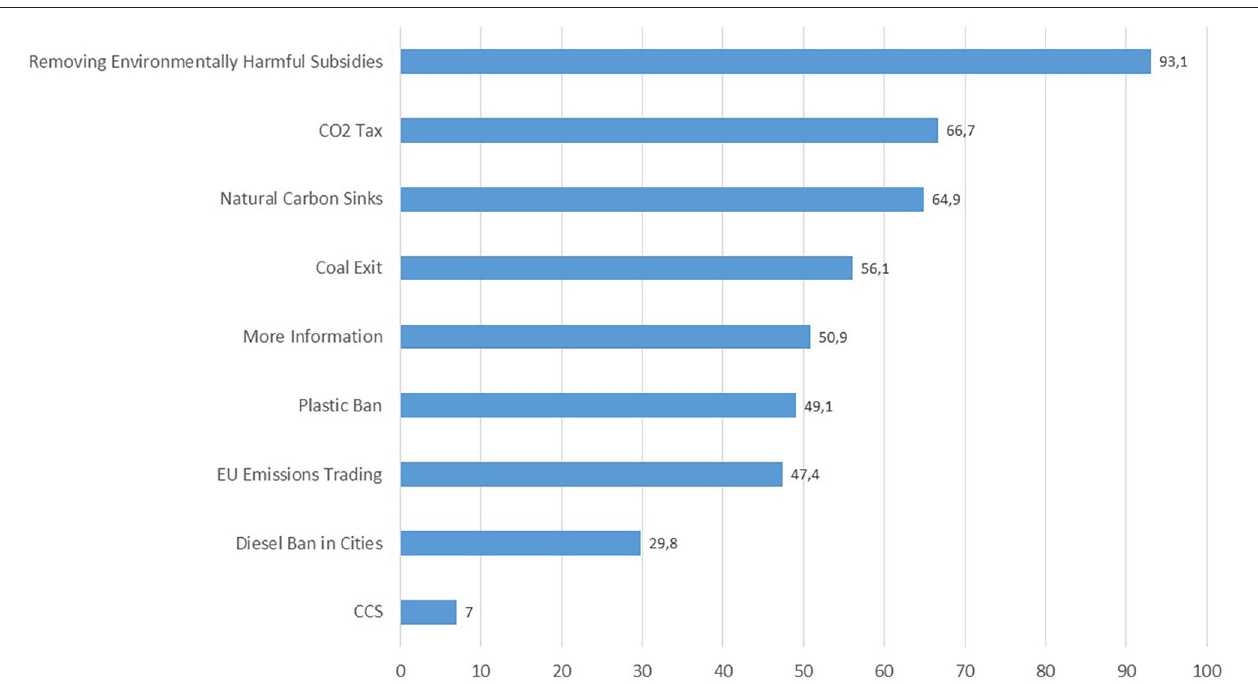
FIGURE 4 | Support of selected climate policy options by KliB households in percent. Source: Own Data.